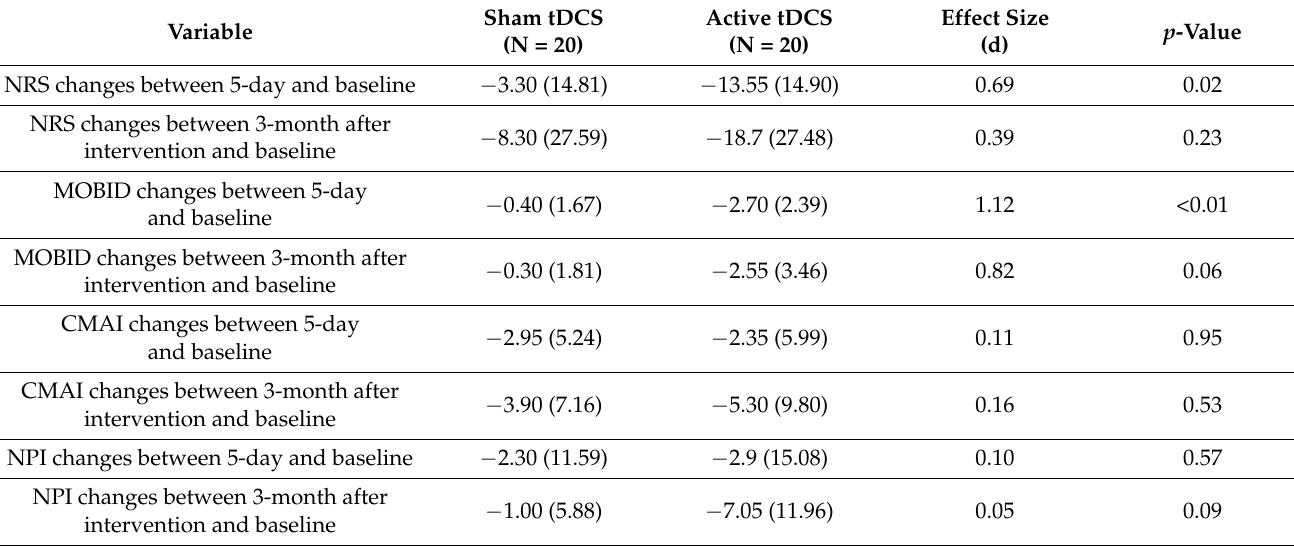
Table 2. Comparison between groups on changes from baseline in clinical pain (NRS, MOBID) and other symptoms (CMAI, NPI).